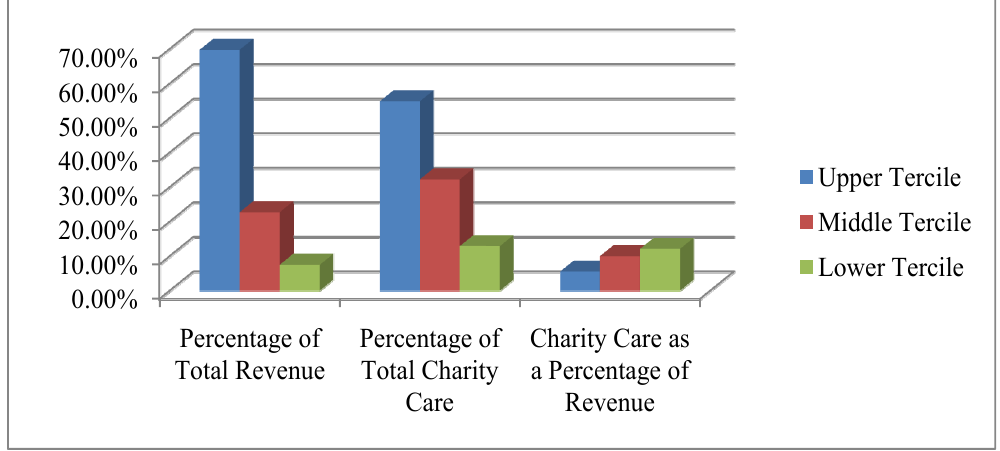
Comparison of Hospital Data by Size, Location, and Income Levels Panel A: Comparison by Size